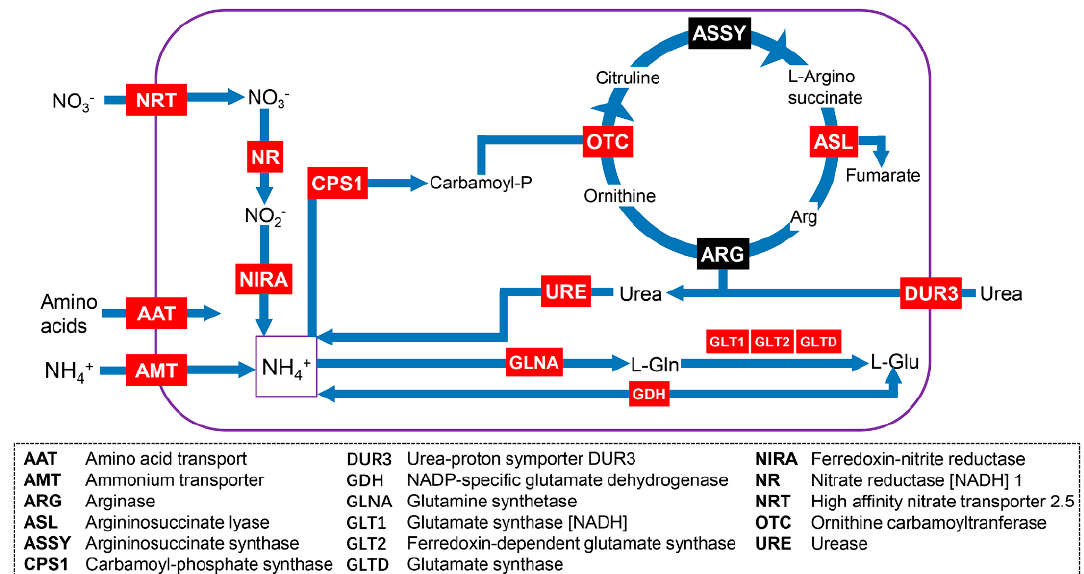
Figure 4. A cell model showing the unigenes of Heterosigma akashiwo involved in nitrogen uptake and metabolism. This model was modified from previous studies [34] . The red and black boxes represent the unigenes that were detected and not detected, respectively. The detail information of these genes is listed in Table S2.